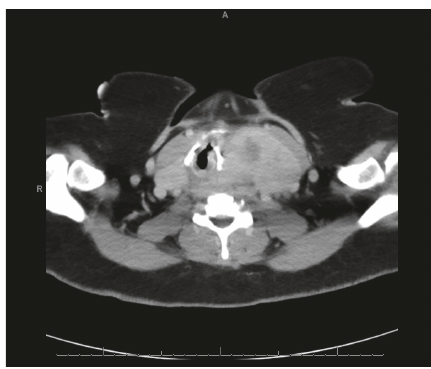
Figure 2: An axial image of the goiter with computed tomography.